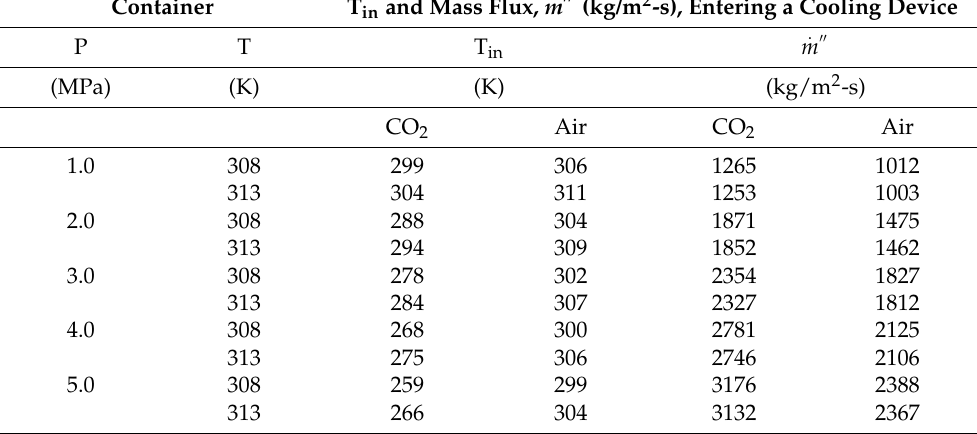
Table 1. Temperature and mass flux, 𝑚(cid:4662) (cid:4593)(cid:4593) (kg/m 2 -s), of CO 2 and air entering a cooling device at MPa after being ex- panded from a high-pressure container.